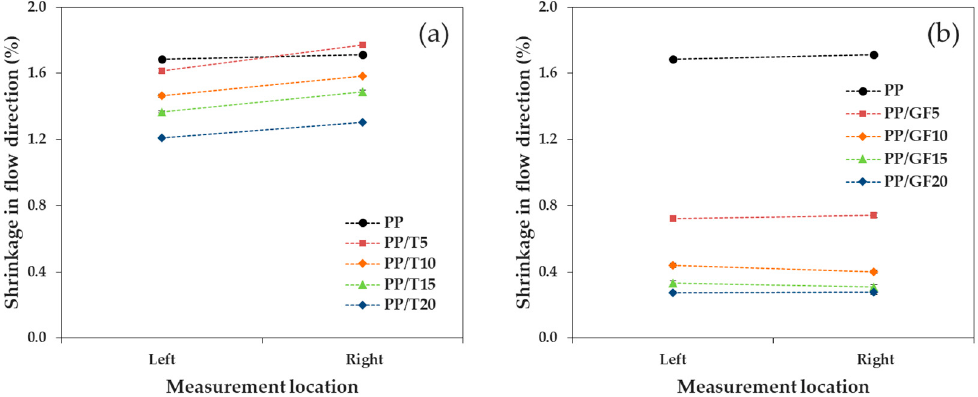
Figure 9. Shrinkage in the flow direction, as a function of the measurement location: ( a ) PP/T and ( b ) PP/GF.